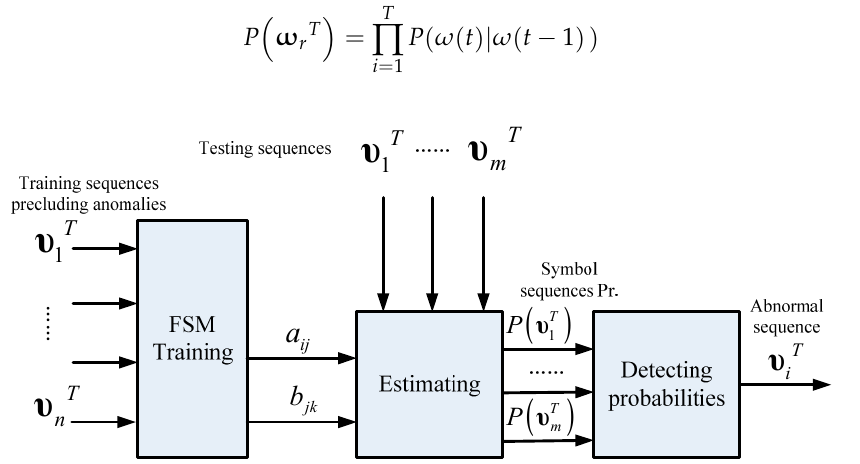
Figure 10. Schematic of anomaly detection using the estimation strategy.